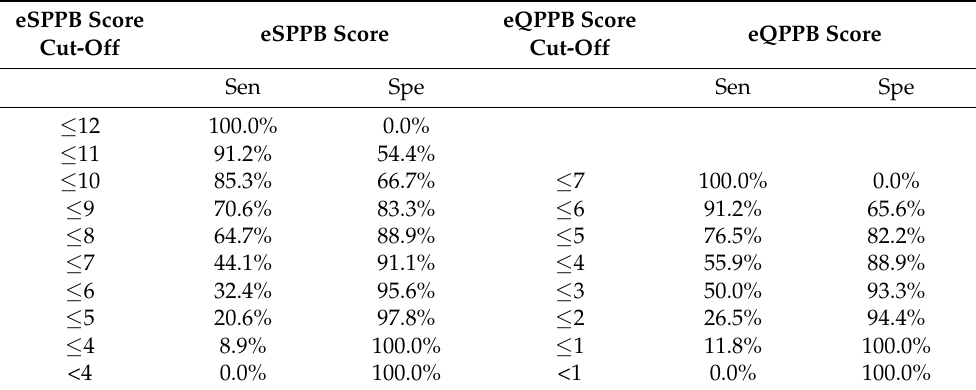
Table 2. Sensitivity (Sen) and specificity (Spe) of eSPPB and eQPPB scores for the prediction of